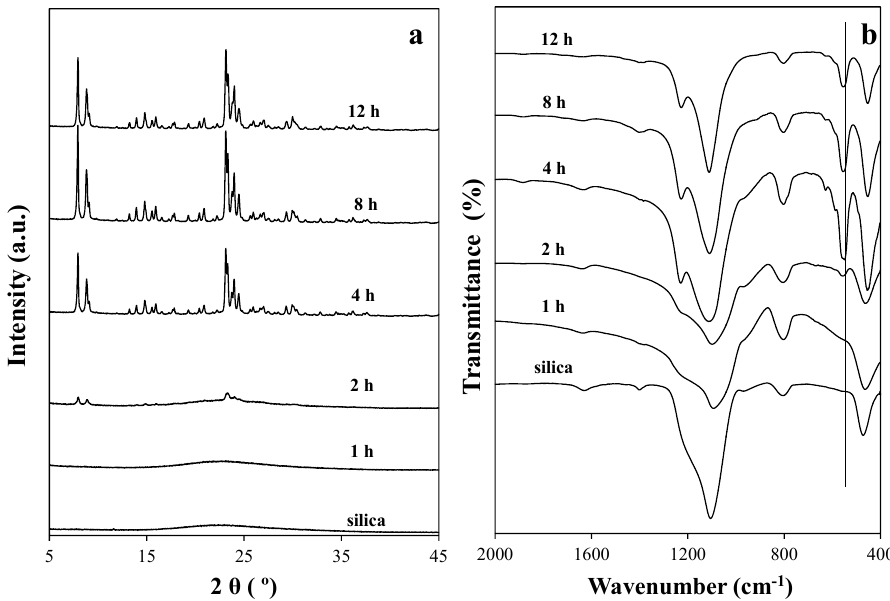
Figure 3. The XRD pattern ( a ) and FTIR ( b ) of silicalite-1 synthesized from silica with particle size of 7 nm.